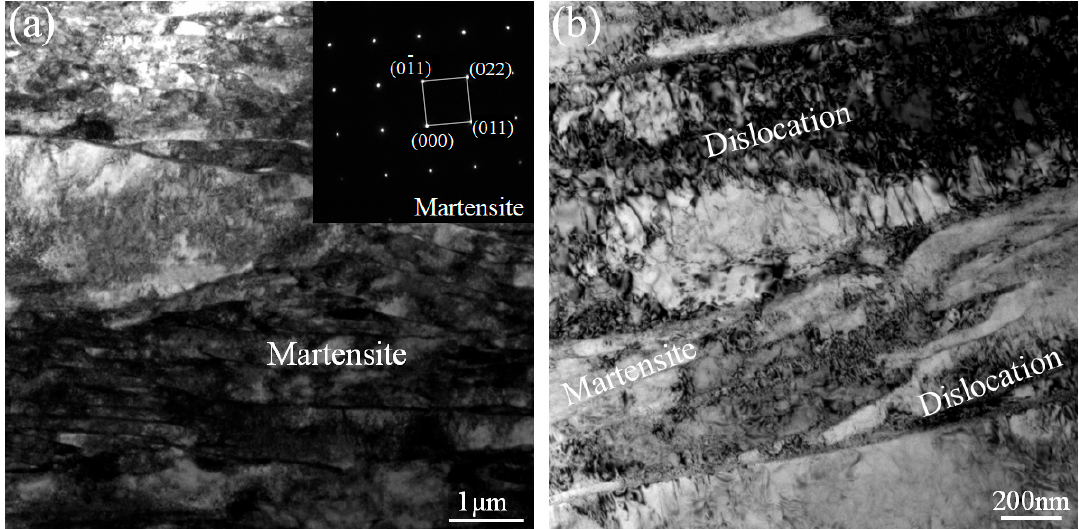
Figure 5. Typical weld metal TEM analysis of the joints produced without PWHT: ( a ) TEM images and diffraction patterns of martensite, and ( b ) dislocation.